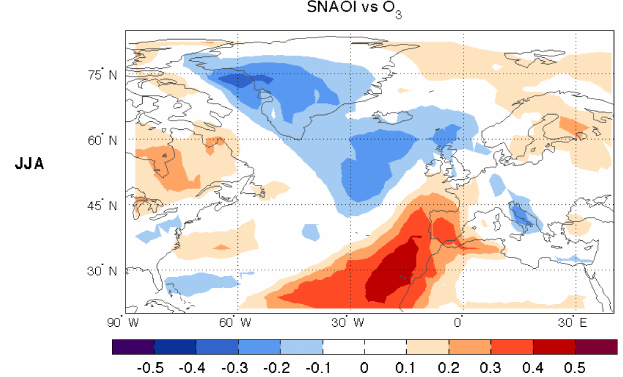
Fig. 11. Correlation between SNAOI – calculated using the new locations – and surface O 3 mixing ratios in summer